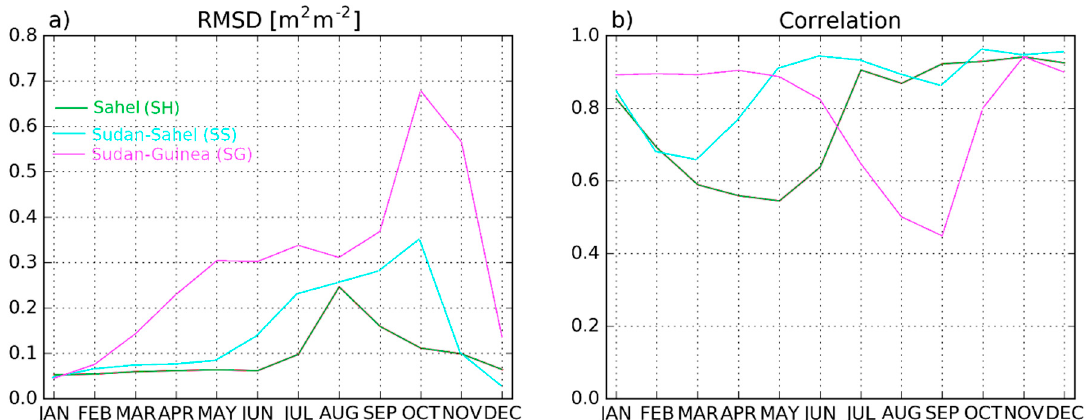
Figure 11. Seasonal ( a ) RMSD and ( b ) correlation of LAI analysis when compared to the observations considering the three climatic regions (SH, SS, and SG) over January 2001 to June 2018 for the LDAS-ERA5 configuration.